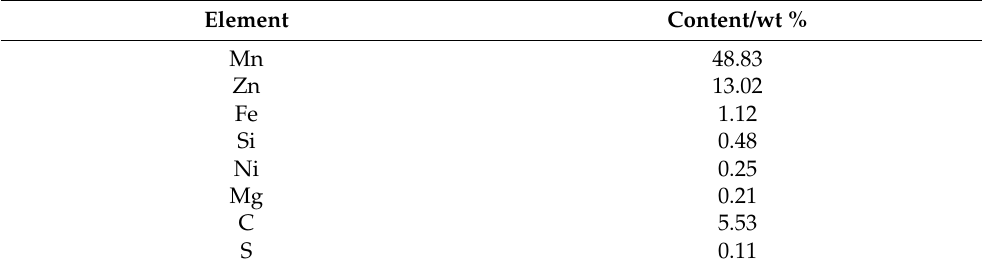
Figure 1. Metal leaching of spent zinc-carbon batteries. Table 1. Chemical composition of the zinc–carbon battery